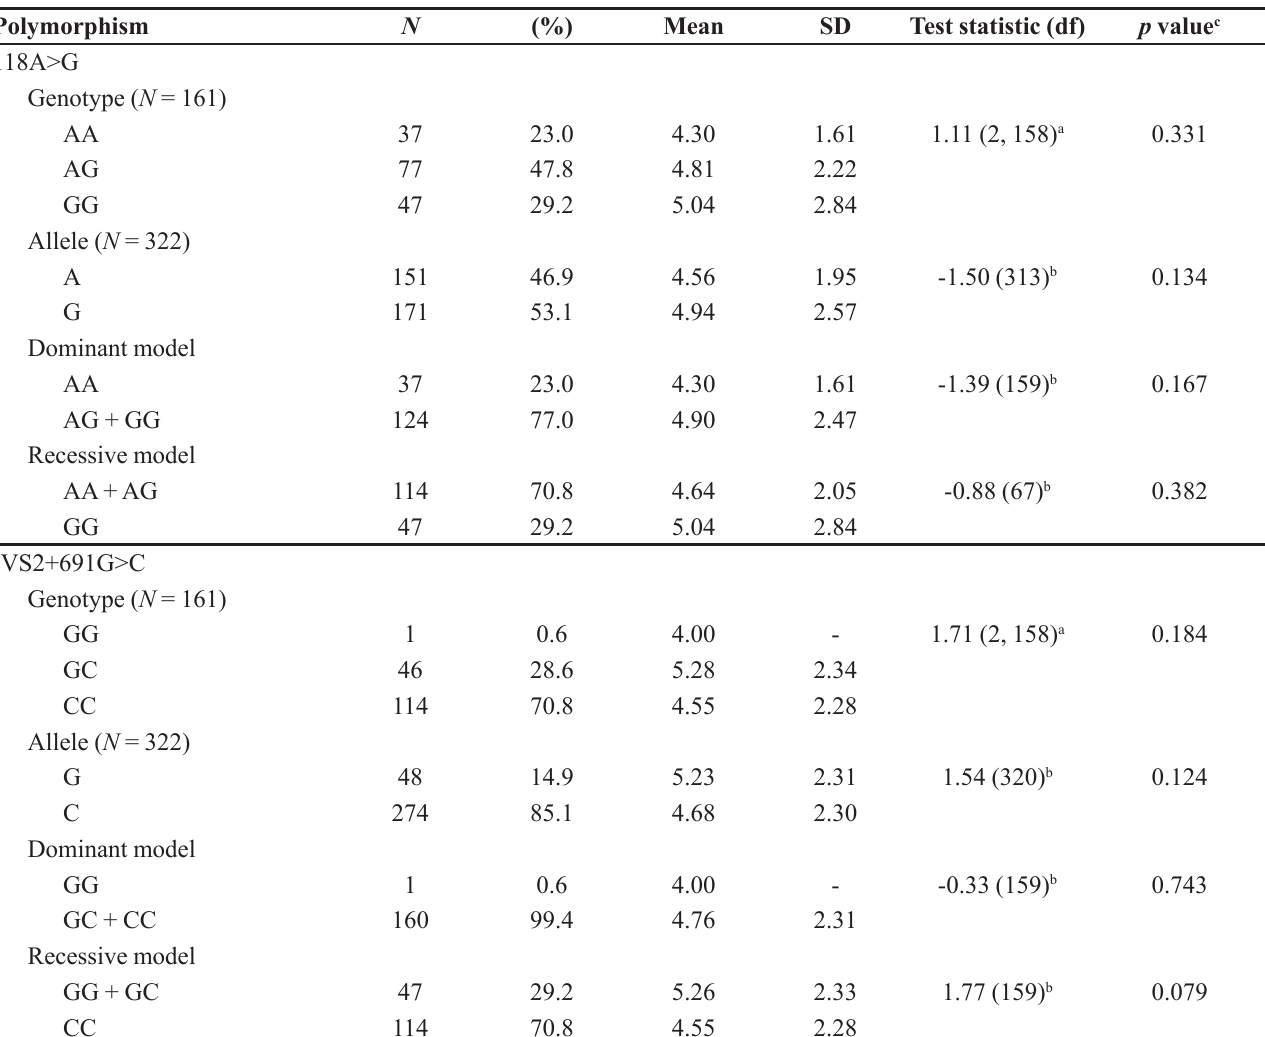
TABLE I - Association between 118A>G and IVS2+691G>C polymorphisms and PSQI scores in opioid-naive Malay Males